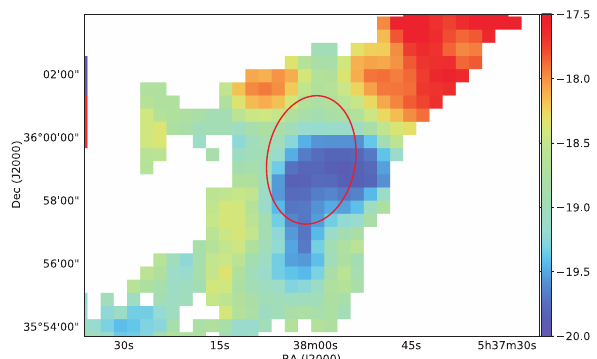
Figure 5. Map of V lsr distribution in WB673 dense clump from CS(2– 1) data. Red ellipse shows size of WB673 from the fit of 12 CO and 12 CO data by Ladeyschikov et al.